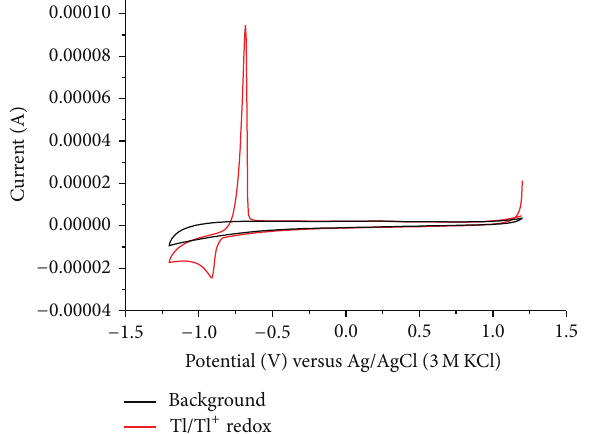
Figure 8: Cyclic voltammograms of glassy carbon electrode in the presence (red) and absence (black) of 1mM TlSO 4 in deaerated 0.5 M Na 2 SO 4 solution.